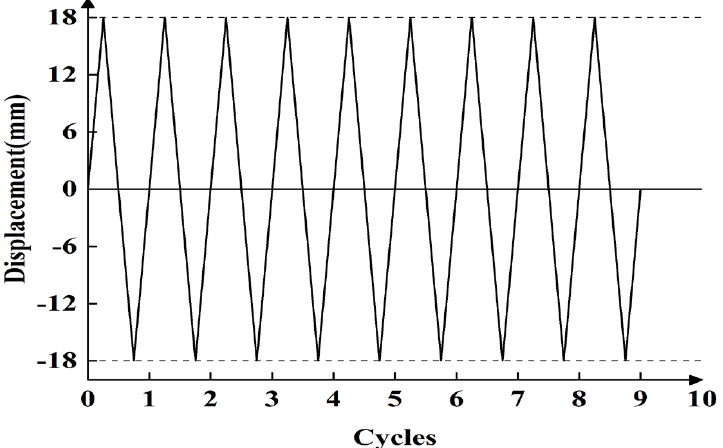
Figure 5. The test loading protocol of the friction energy dissipation composite chord.